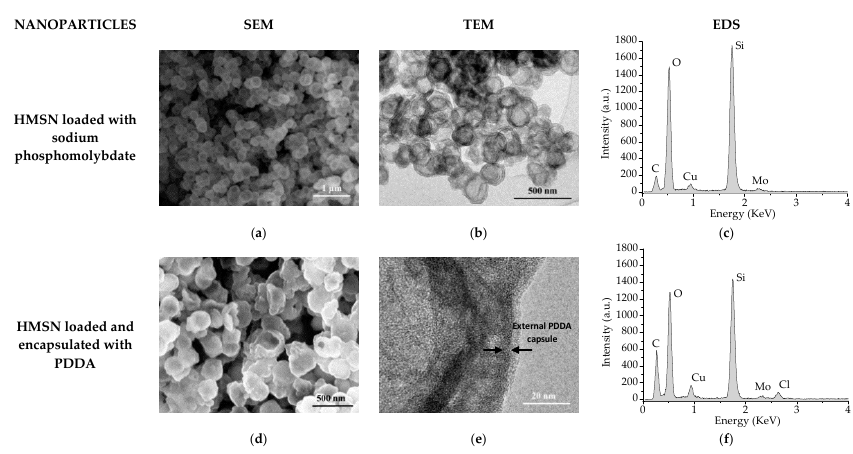
Figure 3. SEM, TEM, and EDS images and spectrums obtained on HMSN loaded with sodium phosphomolybdate before ( a – c ) and after encapsulation with PDDA ( d – f ). The N 2 adsorption-desorption isotherms obtained on HMSN after calcination, and after loading with the inhibitor and after encapsulation with PDDA, are presented in Figure 4a,c,d respectively. In addition, the pore size distribution obtained on HMSN after calcination is presented in Figure 4b. As expected, after calcination, the isotherms corresponded to type IV with a hysteresis cycle (type H2) above P/Po~0.4 and an asymptotic closure at that P/Po value, which is characteristic of mesoporous materials. As can be seen, both S BET and V p decreased after the inhibitor loading stage. Then, as previously indicated by the presence of Mo in the EDS spectrums (Figure 3c,f), the BJH study validates the successful loading of HMSN with sodium phosphomolybdate. Finally, the presence of the external PDDA layer causes, as expected, a noteworthy additional reduction of both S BET (86%) and V p (83%), thus, confirming the successful encapsulation.